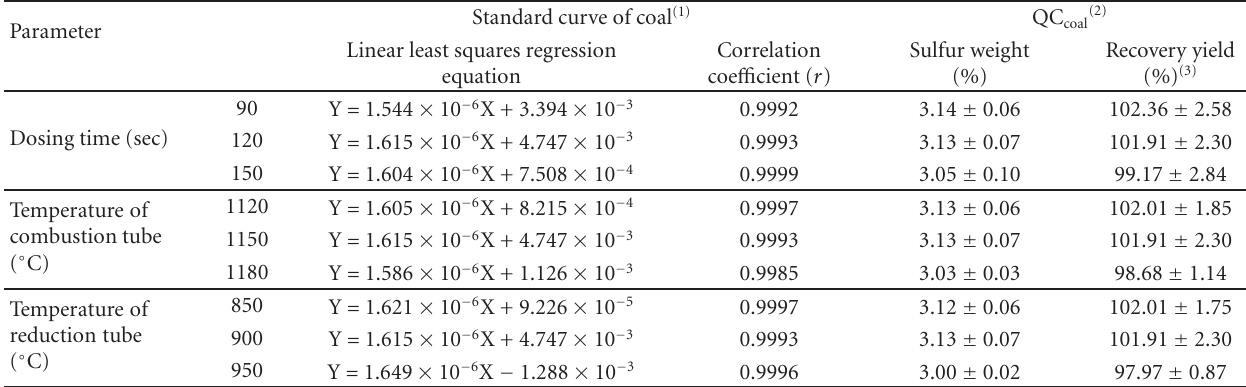
Table 5: Robustness study in the analysis of